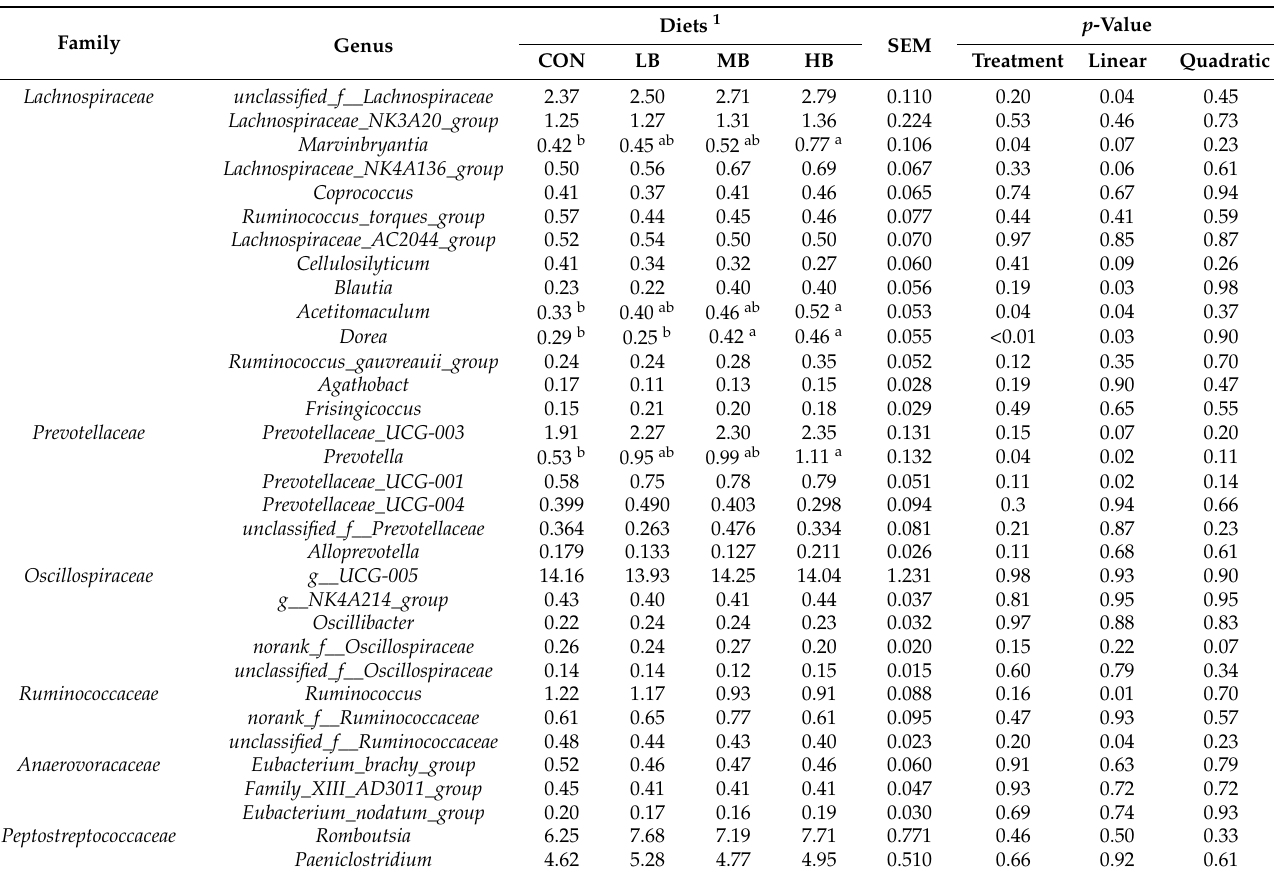
Table 5. The relative abundance of major fecal bacterial genera of lactating Holstein cows fed diets with by-products substituted for